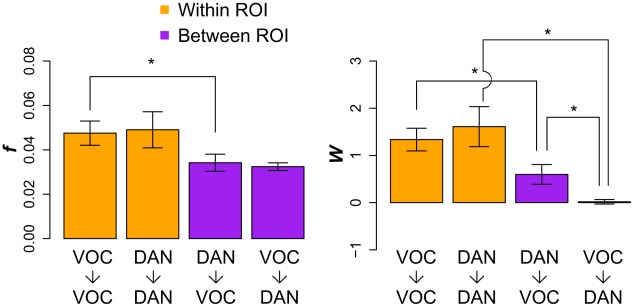
Functional connectivity analysis of Dorsal Attention Network and Visual Occipital Cortex in visual spatial attention.The f and W summary statistics were computed from LASSO-GC for each of 60 ROI pairs and 6 subjects, and then averaged over pairs and subjects. For each ROI pair, one ROI was in the Dorsal Attention Network (DAN) and the other was in Visual Occipital Cortex (VOC). The bars represent mean f and W summary statistics for VOC-to-VOC connectivity, DAN-to-DAN connectivity, DAN-to-VOC connectivity, and VOC-to-DAN connectivity. Error bars represent the standard error of the mean. Significant differences from paired-sample t-tests are marked (*: p<0.05).